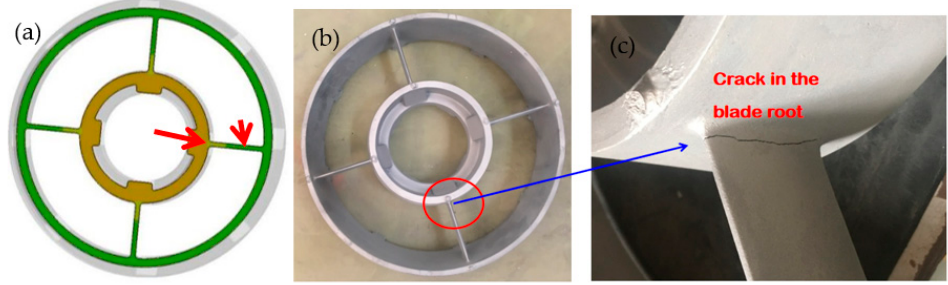
Figure 9. Crack at the root of the supporting plate of TiAl alloy case simulation. ( a ) temperature field under 8× cross runner, ( b ) photos of the actual TiAl case, and ( c ) a crack found in the blade root.